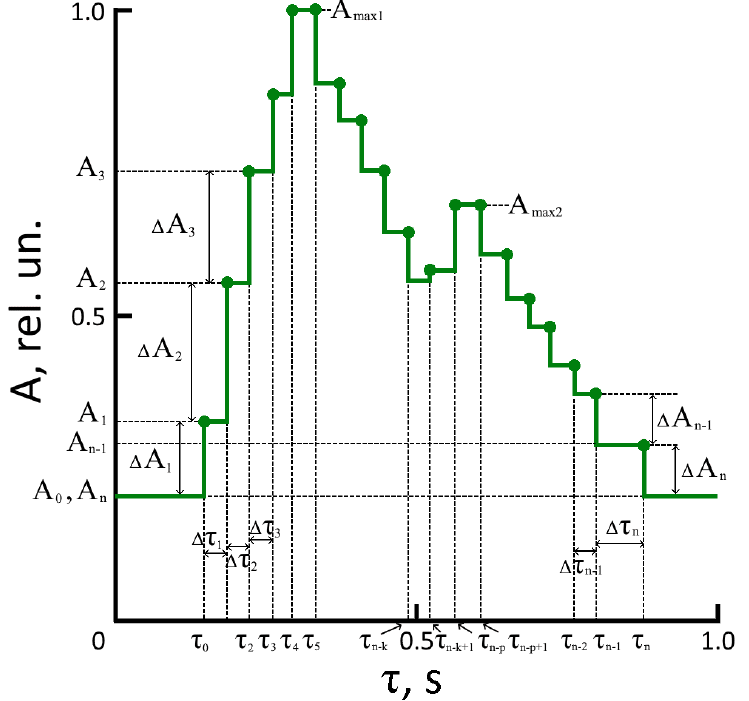
Figure 2. The pulse waveform (one period) recorded on the finger.